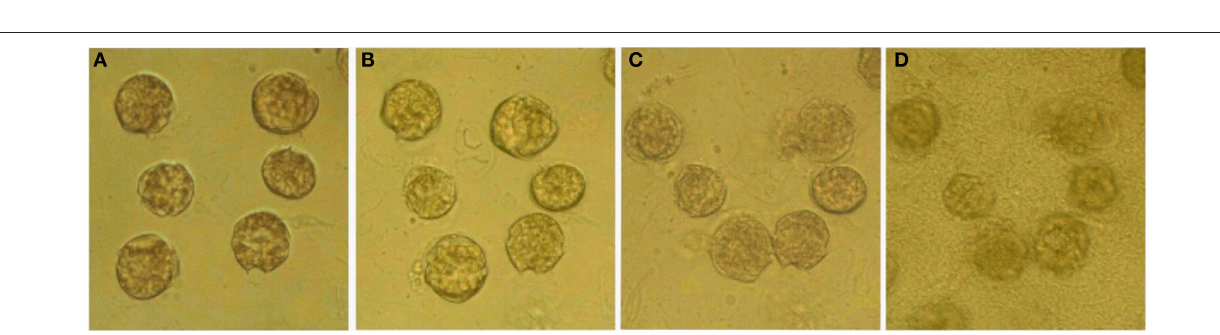
FIGURE 6 | Variation of algal structure after bacteria were added to A. tamarense cultures. (A–D) respectively present cells treated with bacteria for 0, 10, 30min and